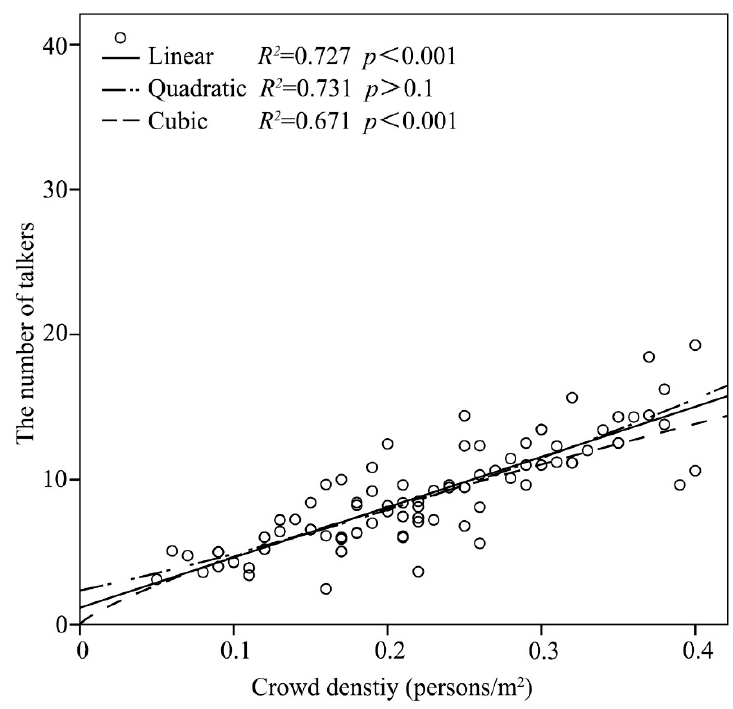
Figure 6. The relationship between crowd density and the number of talkers with three regression curves in the Di zone.